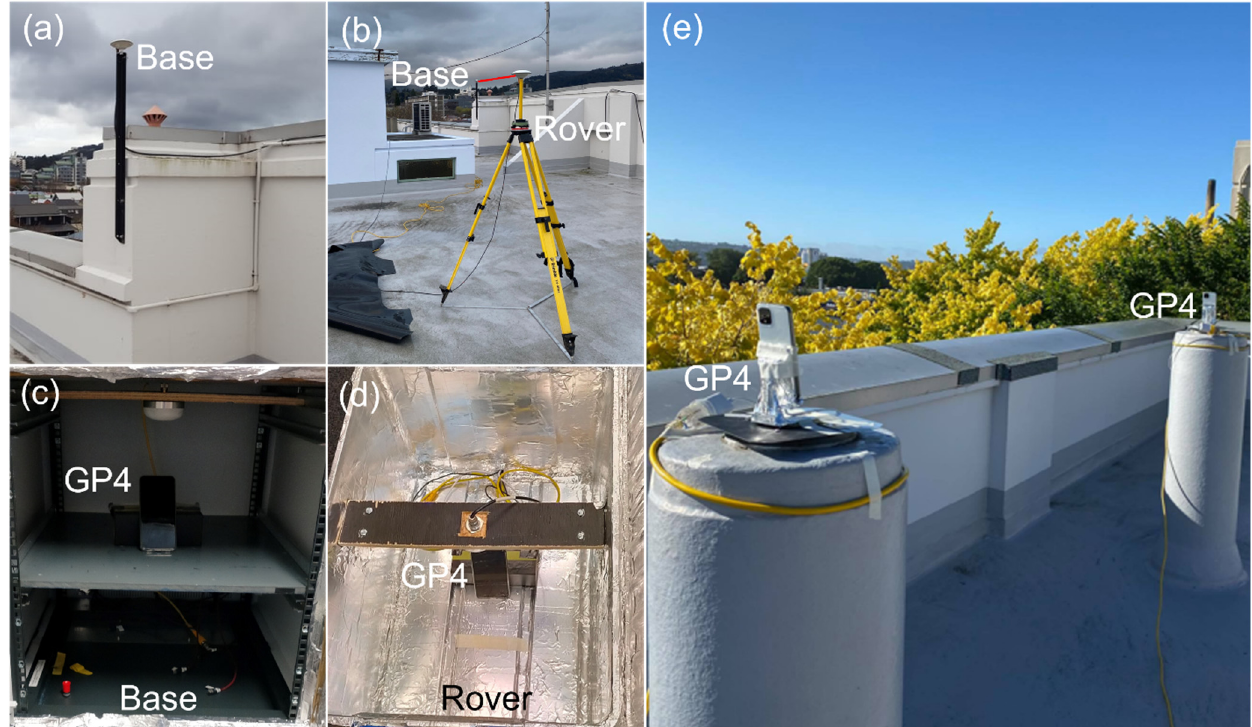
Figure 1. GP4 smartphones in a short-baseline setup configuration with external antennas ( a , b ) inside an RF shielding box ( c , d ), and with the smartphone internal antennas ( e ) on the rooftop of the building of the School of Surveying in Dunedin, New Zealand.